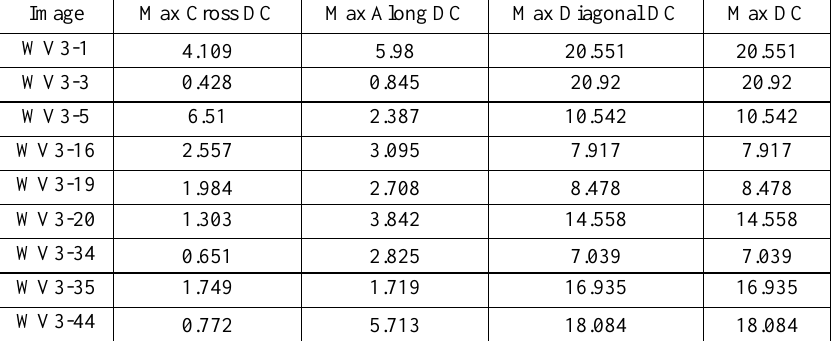
Table 7. The maximum deviation coefficients of WV3 dataset. The deviation coefficients in the table have been multiplied by 10 4 . The results show that the geometric quality of the image obtained by the same satellite is uneven. The